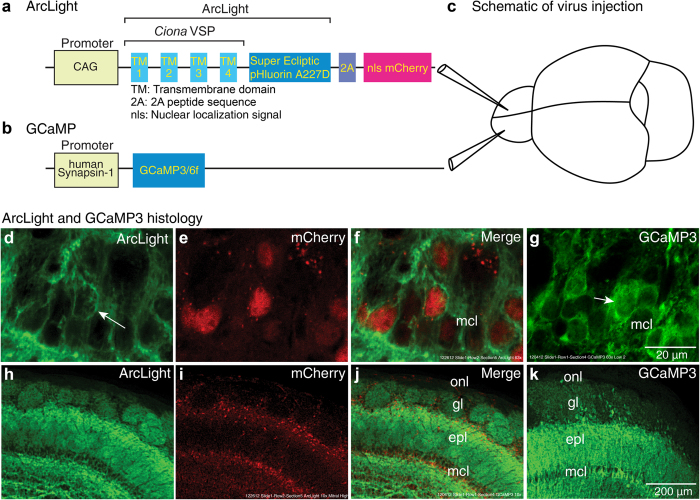
Schematic of constructs, virus injections, and results of histological examination of the fluorescence of ArcLight and GCaMP3 in injected olfactory bulb hemispheres.(a-b) Constructs for (a) ArcLight and (b) GCaMP3/6f AAV1 vectors. The mCherry in the ArcLight construct includes a nuclear localization sequence to facilitate identification of transduced neurons. (c) Each AAV vector was injected into an olfactory bulb hemisphere at least 10 days prior to imaging. (d) High magnification confocal photomicrographs of ArcLight demonstrate membrane localization (arrow). (d) ArcLight, (e) mCherry and (f) merge. (g) High magnification photomicrograph of GCaMP3 fluorescence. The GCaMP3 fluorescence seems to fill the cytoplasm (arrow). (h-k) Low magnification confocal photomicrographs demonstrate expression patterns of the ArcLight (h-j) and GCaMP3 AAV vectors (k). Both vectors appeared to be selective for mitral/tufted cells in the outer layers of the bulb. Scale bars in g and k apply to d-g and h-k, respectively. onl, olfactory nerve layer; gl, glomerular layer; epl, external plexiform layer; mcl, mitral cell layer.